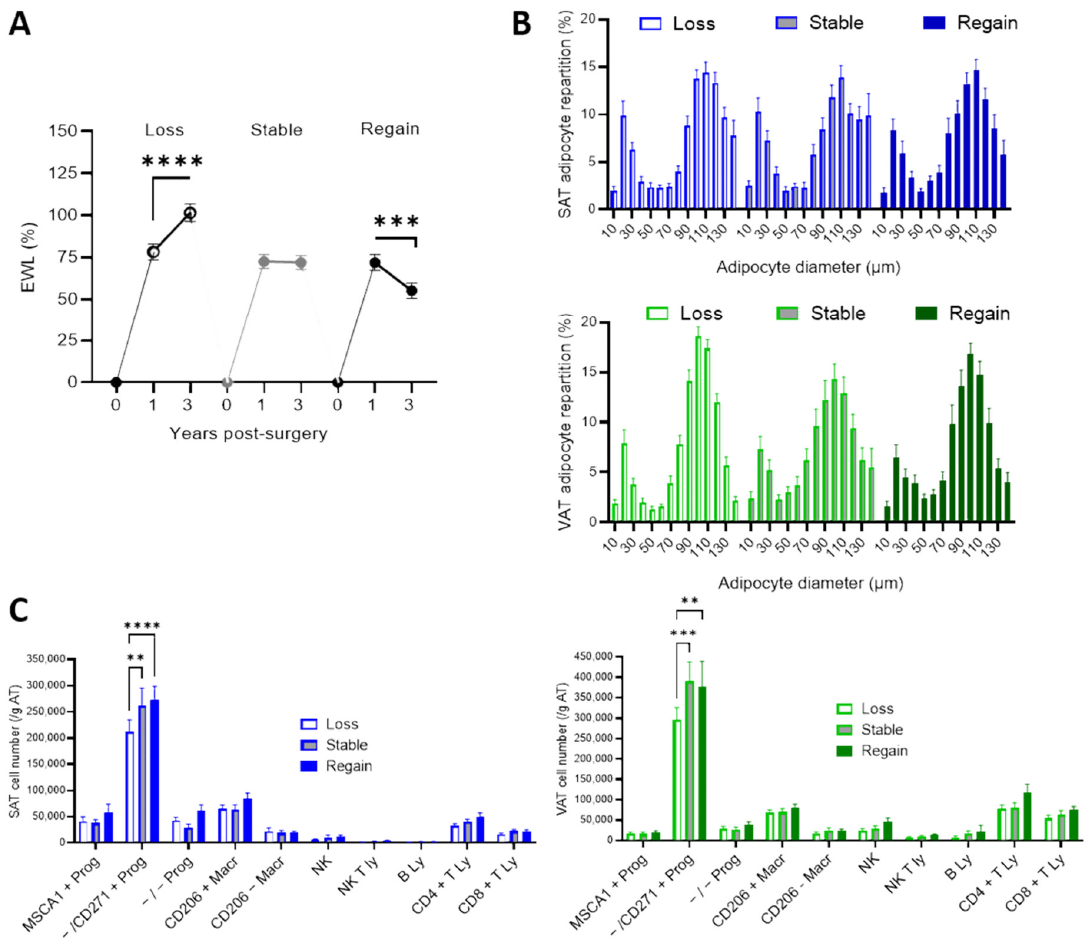
Figure 4. Trajectories of weight loss and cell phenotypes of expanded SAT and VAT. ( A ) Patients were grouped in tertiles ( n = 26) according to the differences between EWL at three years and EWL at one year post-surgery with further weight loss (loss trajectory, stable weight loss (stable trajectory) and weight regain (regain trajectory); one way ANOVA followed by Tuckey multiple comparison test, ***, p < 0.001, ****, p < 0.0001. ( B ) Adipocyte diameter repartition in SAT (blue) and VAT (green) of patients according to weight loss trajectories. Values are means ± SEM of n = 18 to 20 patients. ( C ) Stromal cell numbers determined by flow cytometry analyses in SAT (blue) and VAT (green) of patients according to weight loss trajectories. Values are means ± SEM of n = 22 to 24 patients, two-way ANOVA followed by Sidak multiple comparisons test, **, p < 0.01, ***, p < 0.001.****, p < 0.0001.